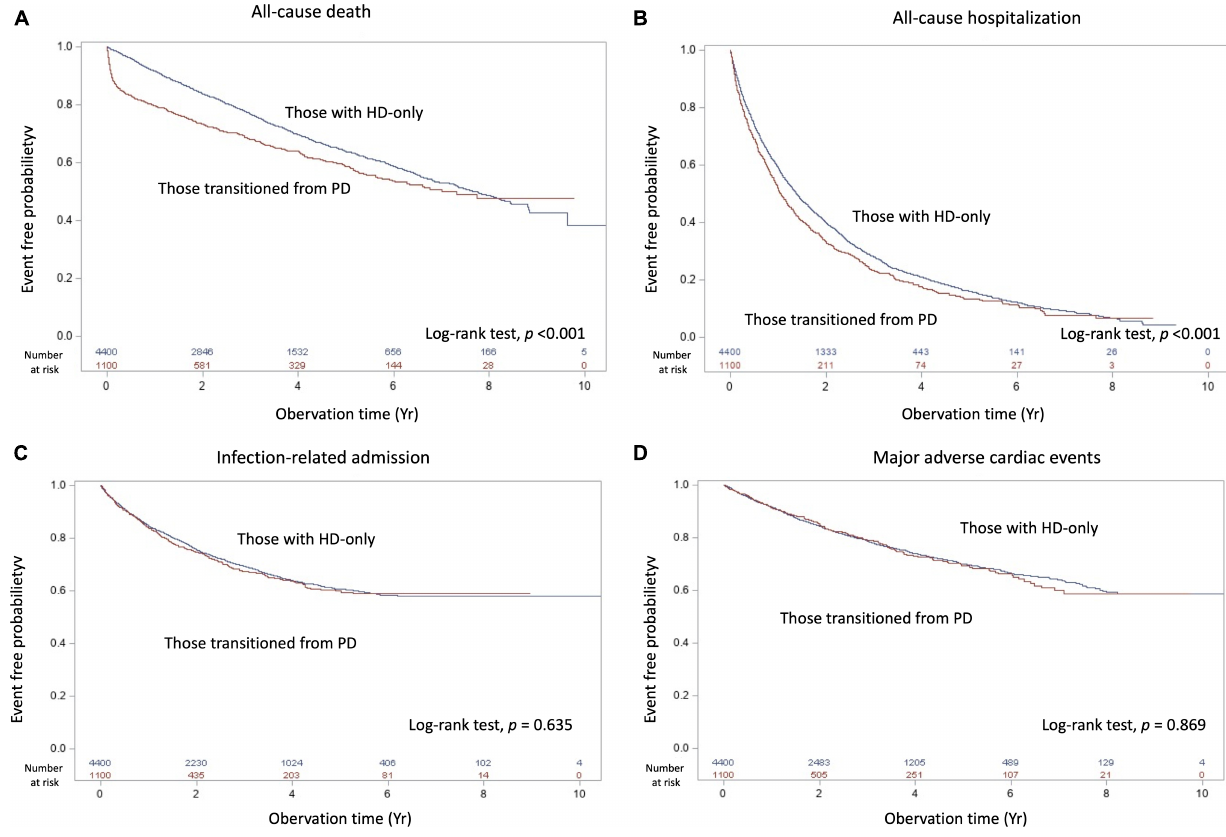
Transitioned from PD vs. HD-only All-cause death All-cause